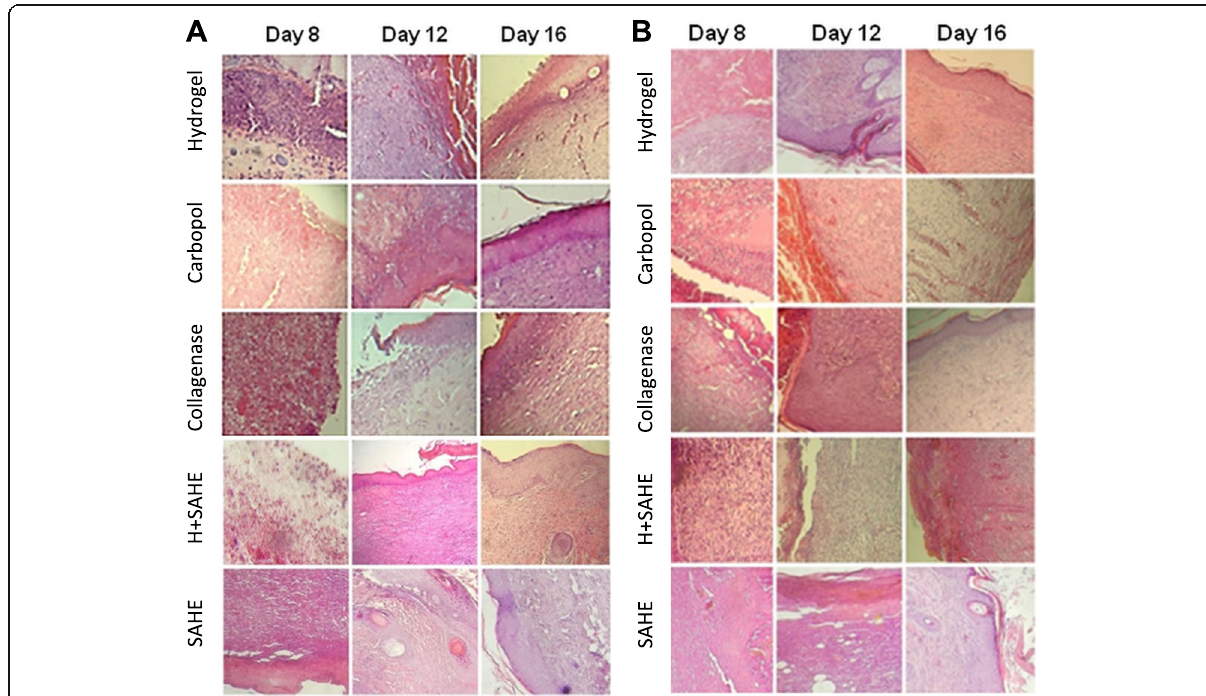
Fig. 6 Skin histology of the controls ( a ), and the diabetic animals ( b ), on days 8, 12, and 16, after the wonder lesion treatments with Hydrogel; Carbopol; Collagenase with Chloramphenicol®; H + SAHE; SAHE. Staining H&E, 10 × 40 magnification